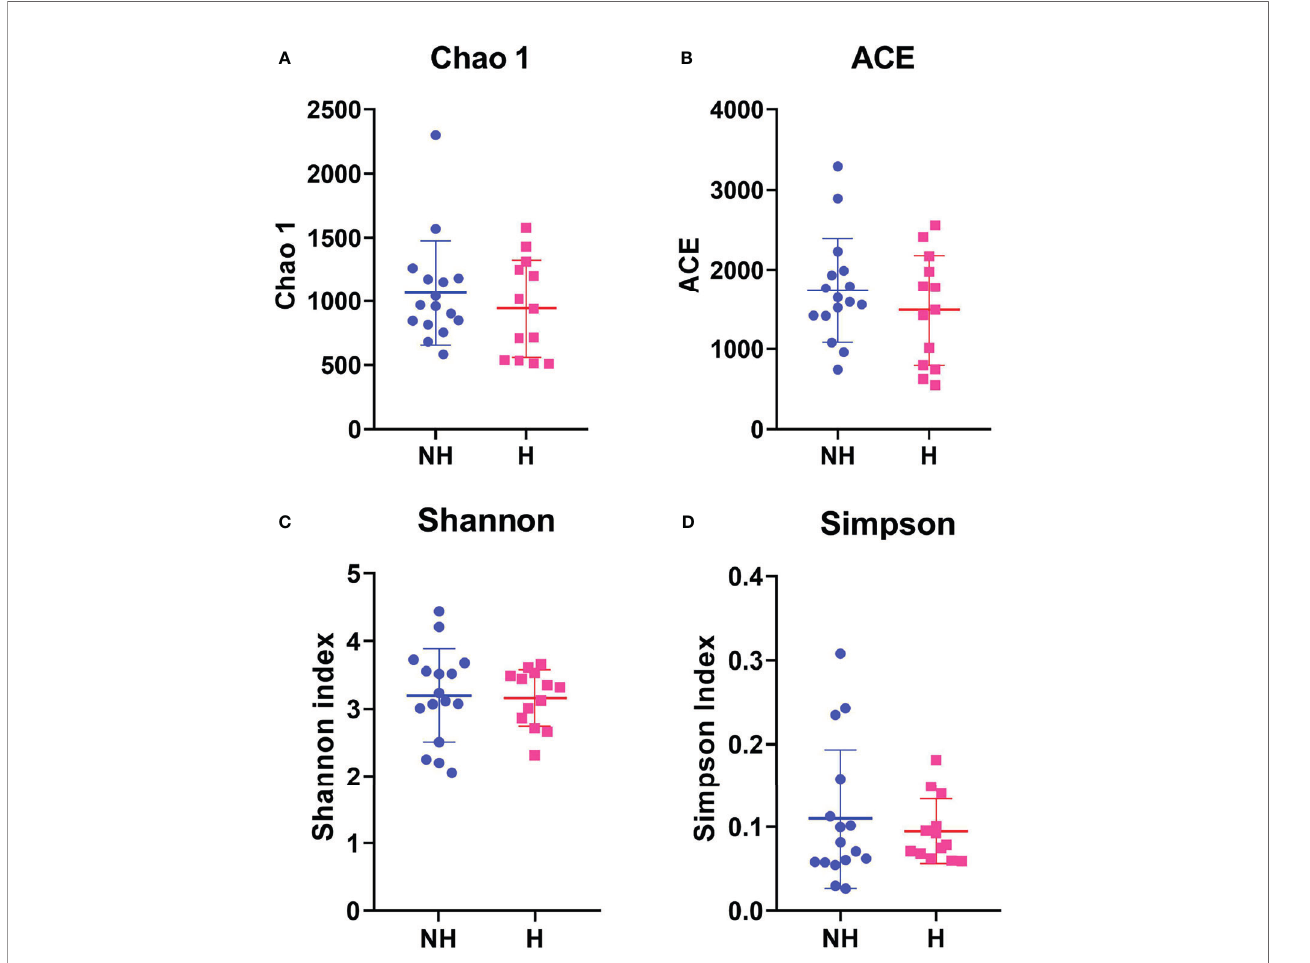
FIGURE 1 | Comparative a -diversity analysis by (A) Chao1, (B) ACE estimator, (C) Shannon, and (D) Simpson Index indicating microbiome differences between non-hematochezia (NH) and hematochezia (H) subjects. Error bars indicate